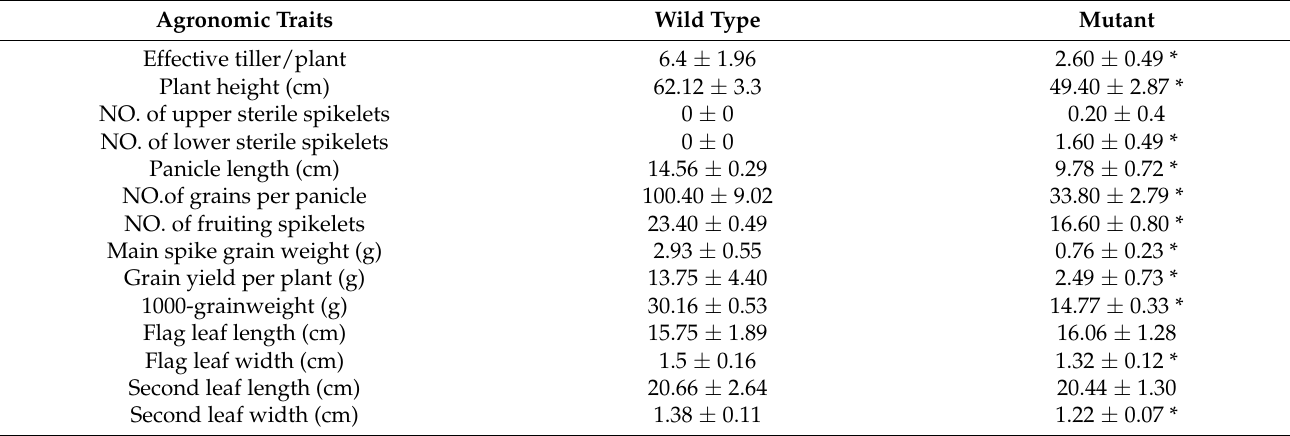
Table 1. The main agronomic traits of the WT and